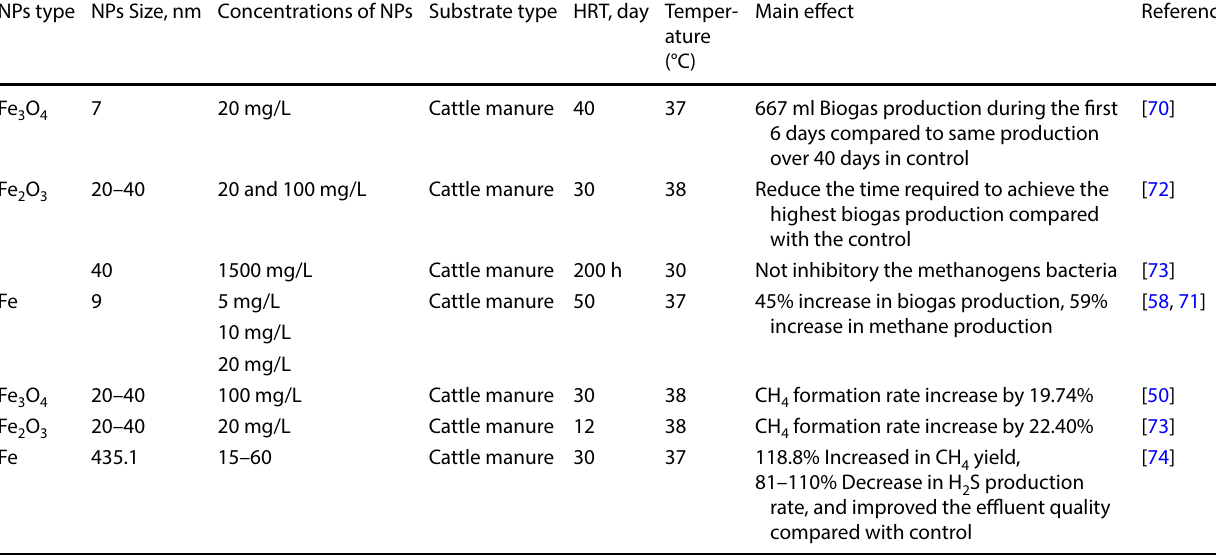
Table 1 Effects of iron nanoparticles on the performance of biogas production process and effluent quality NPs type NPs Size, nm Concentrations of NPs Substrate type HRT, day Temper-